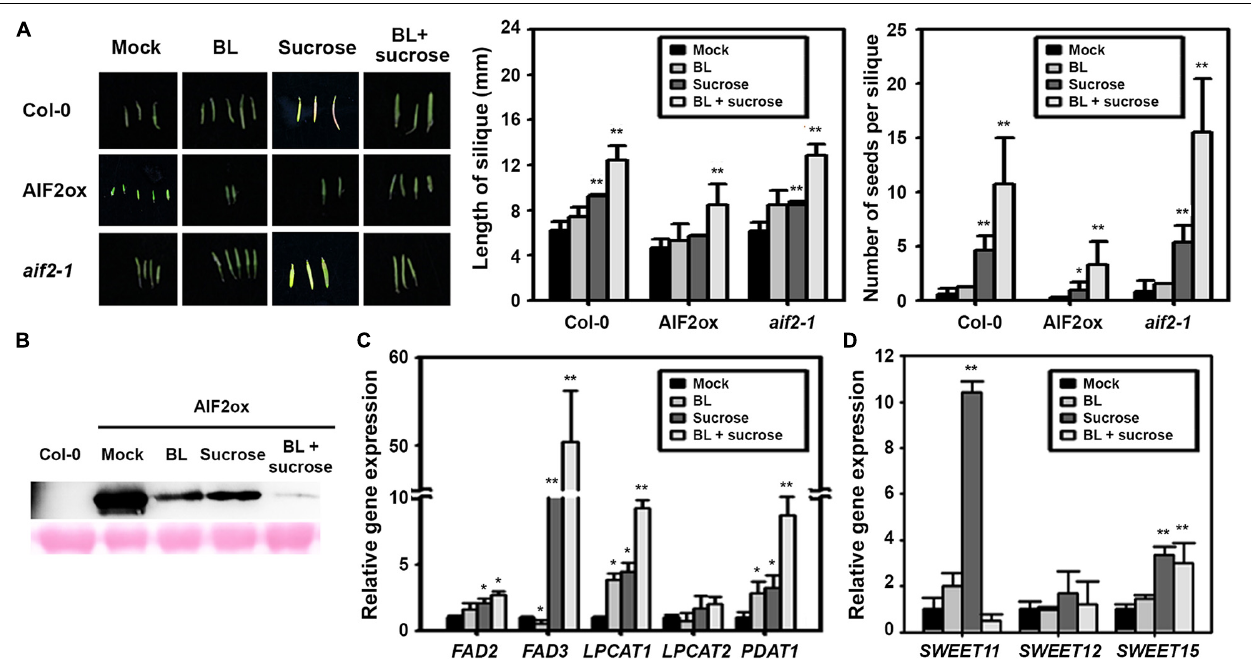
FIGURE 8 | Sucrose- and brassinosteroid-induced suppression of AIF2 stability and silique phenotypes. Flowers in between DAP3.5 to DAP4 ( n > 40 for each experiment) were collected and cultured for 9 days in solid MS media containing brassinolide (BL, 10 - 9 M) supplemented with or without 3% sucrose (w/v). (A) Length and seed numbers of in vitro -cultured silique. (B) Western blot analysis of AIF2-EGFP expression in siliques of in vitro -cultured p35S:AIF2-EGFP transgenic lines (AIF2ox) (C,D) Total RNA was extracted from in vitro -cultured siliques of the AIF2ox, and the transcript expression for lipid biosynthesis genes (C) and sucrose transport-related genes (D) was measured using qRT-PCR. Relative expression of each gene is normalised as a ratio of the mock-treated plants, which was set to 1. Statistical difference from the mock-treated control is indicated by an asterisk (*) at P < 0.05 and two asterisks (**) at P <